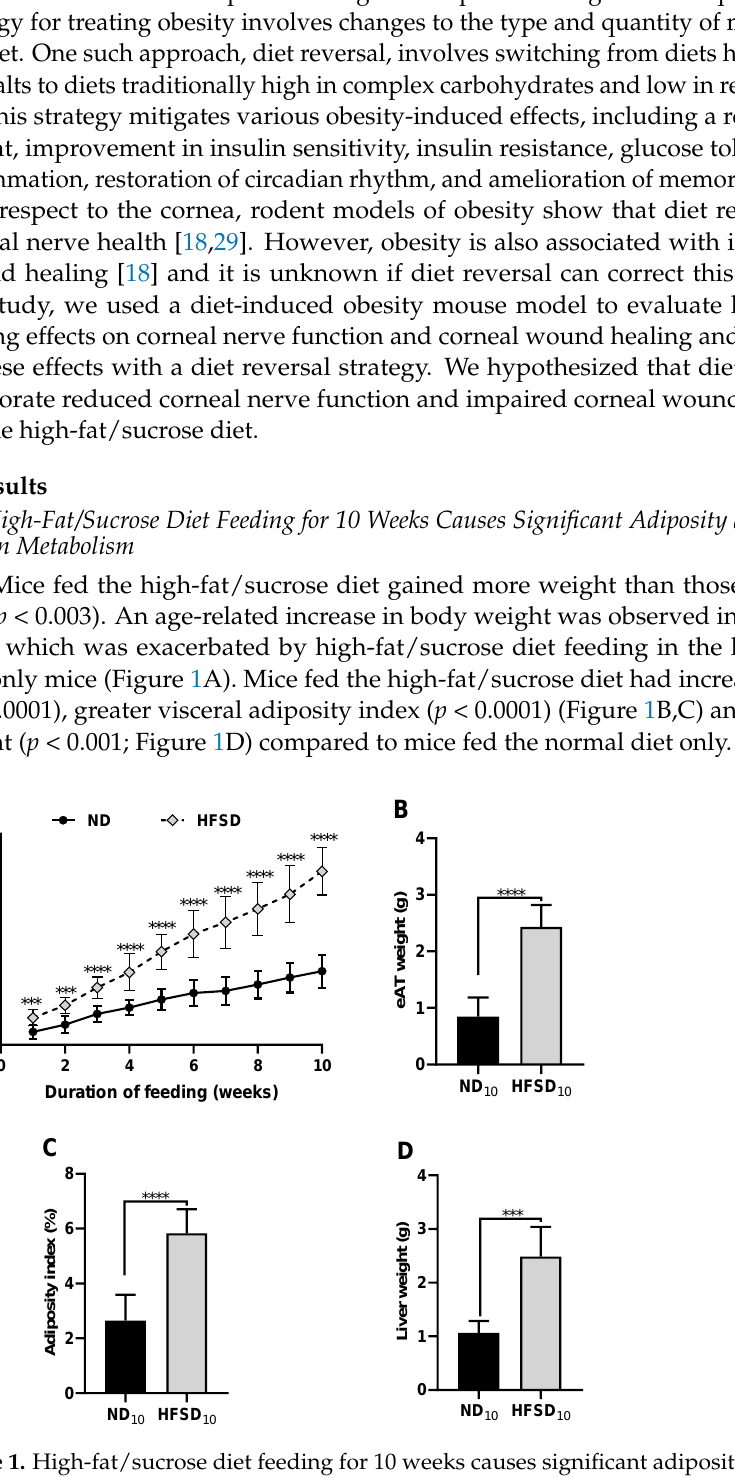
Figure 1. High-fat/sucrose diet feeding for 10 weeks causes significant adiposity and liver weight gain. ( A ) Cumulative weight change ( B ) Epididymal adipose tissue weight, ( C ) body adiposity index, and ( D ) liver weight in mice fed a normal diet or high-fat/sucrose diet ( n ≥ 6 per group). Data expressed as means ± SD. ND 10 —10-week normal diet; HFSD 10 —10-week high-fat/sucrose diet; *** p ≤ 0.001, **** p ≤